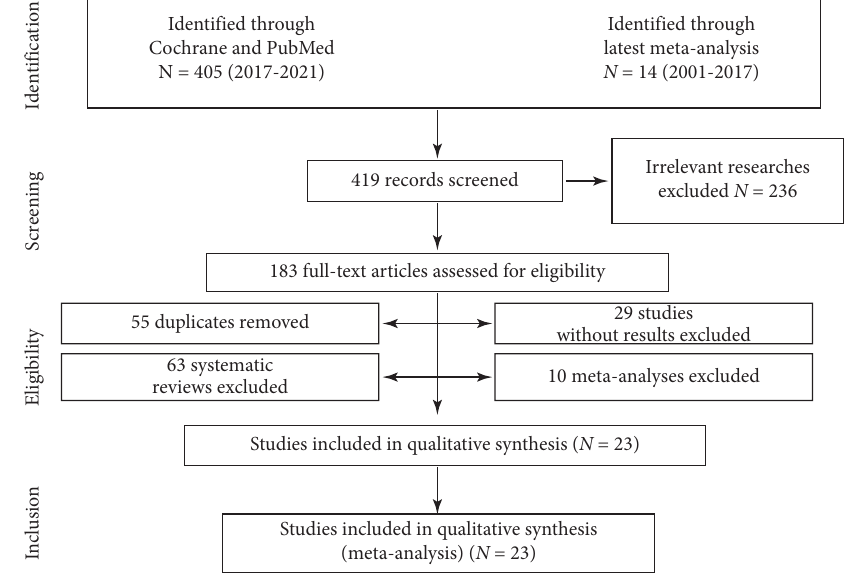
Figure 1: PRISMA flow diagram of included